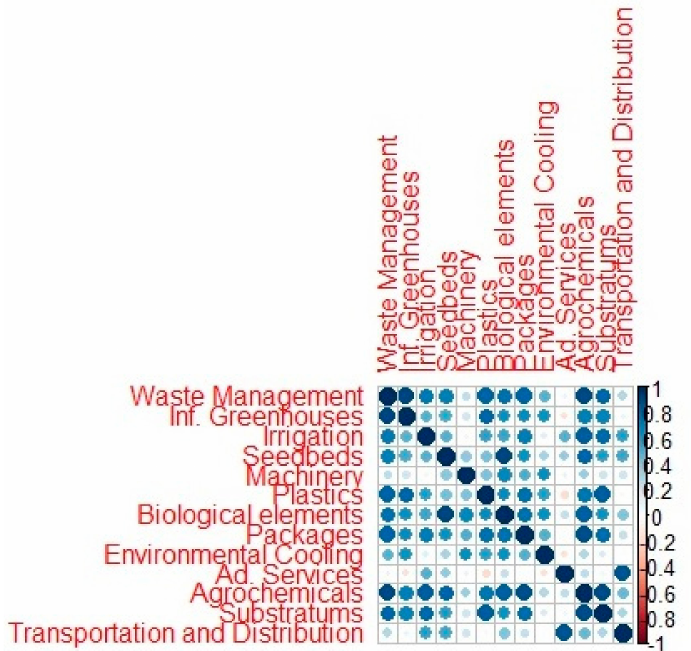
Figure A1. Correlation analysis of competitiveness